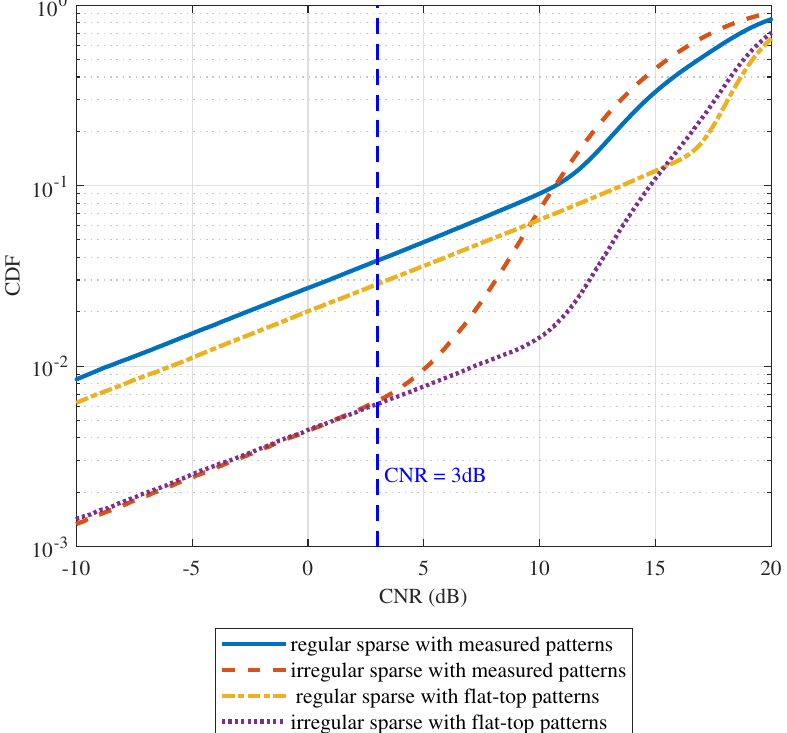
Figure 16. By applying the measured radiation patterns, the CDF of the CNR can be found. The irregular array still outperformed the regular array by a significant margin. This holds for both the simulated and measured